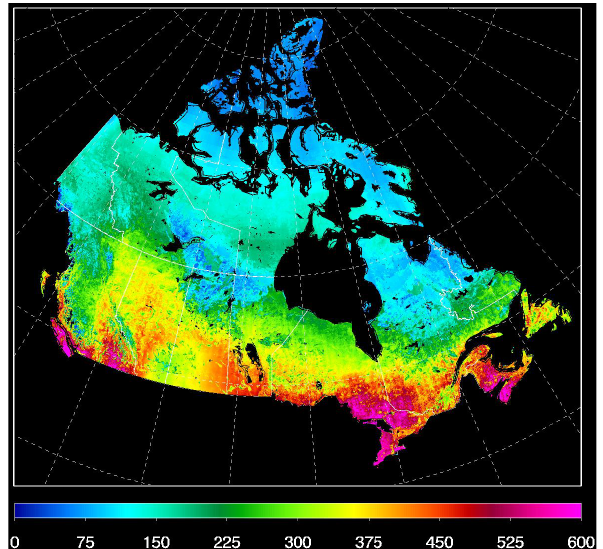
Fig. 9. Spatial distribution of the mean annual evapotranspiration (mmyr − 1 ) modeled over Canada’s landmass for the 30yr of 1979– 2008.